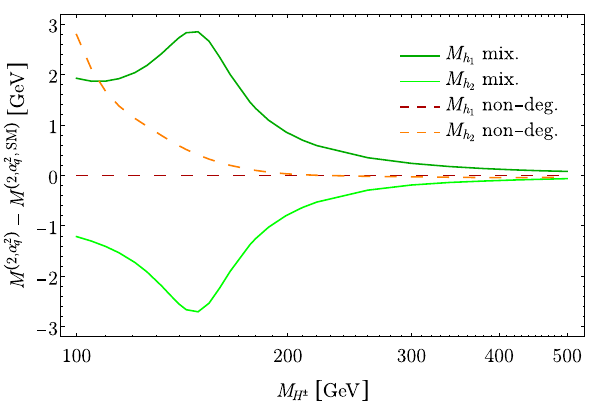
Fig. 9 Difference between the predicted masses (in the expansion formalism with DR field counterterms at μ UV = m t ) including the (cid:2) (cid:3) α α , α 2 O gaugeless corrections for all states ( M (α 2 q ) ), and those q s q obtained with 2L corrections only applied to the SM-like direction ( M (α 2 q , SM )